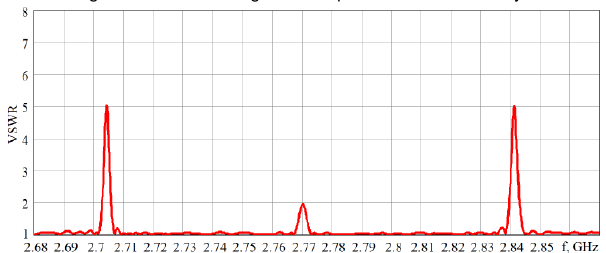
FIGURE 11. In a typical implementations of the frequency characteristics of the standing wave ratio for voltage at the input of the antenna array.